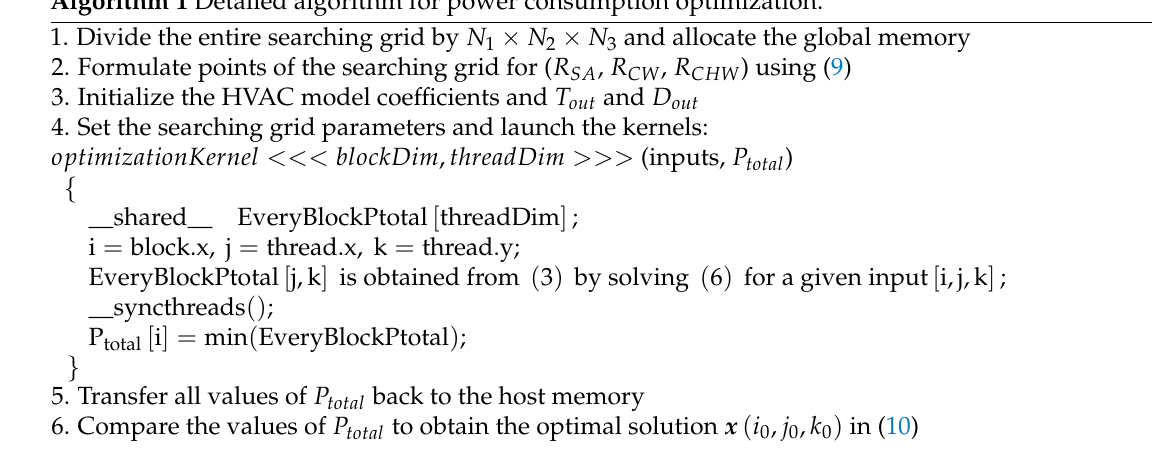
Algorithm 1 Detailed algorithm for power consumption